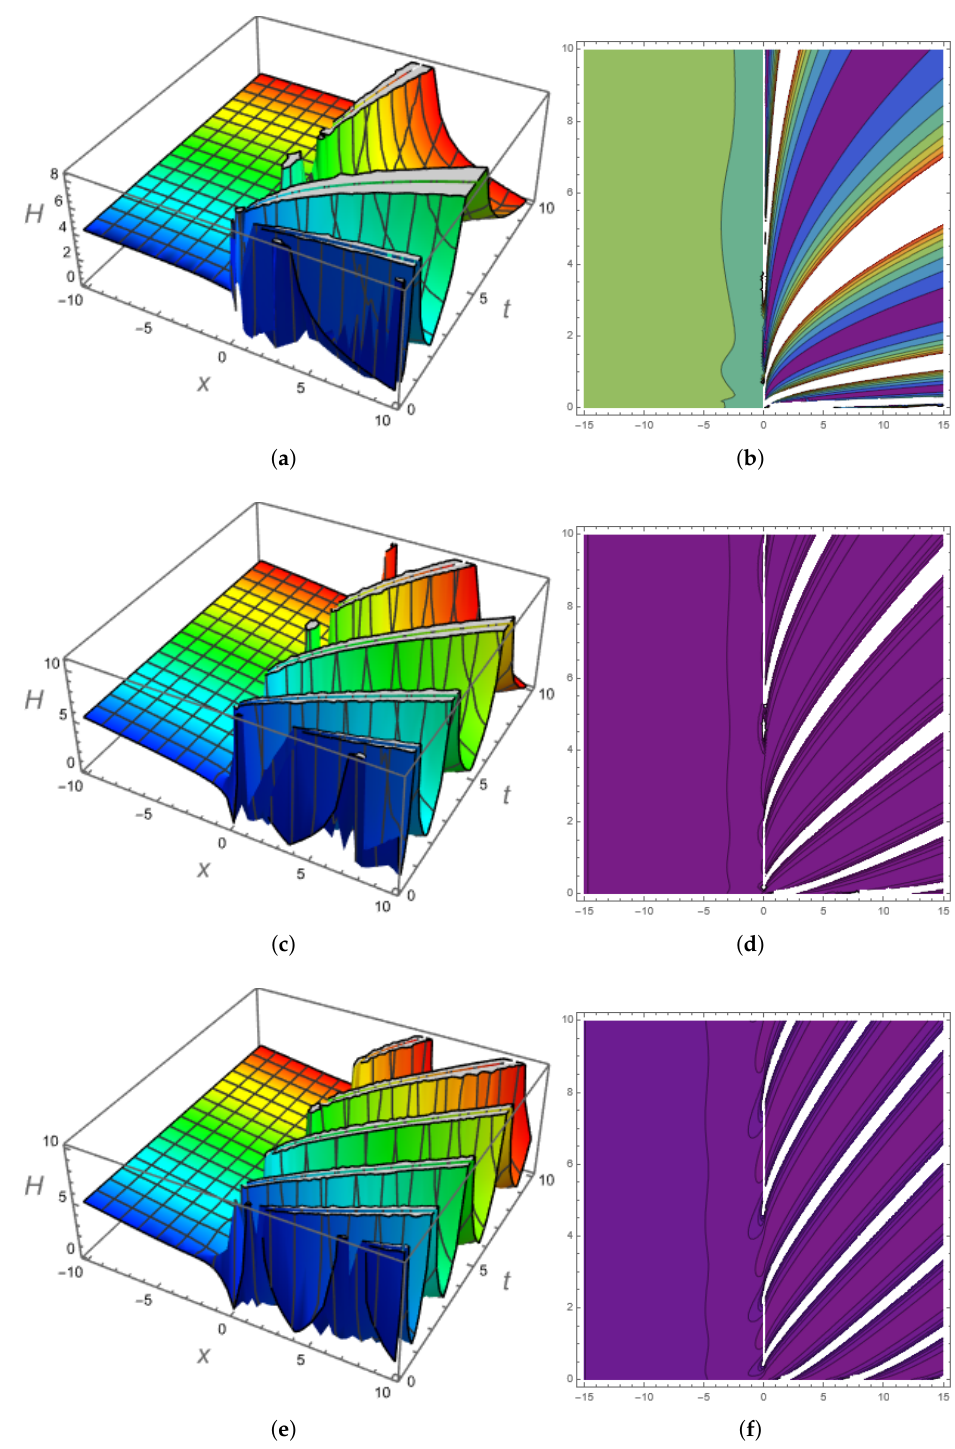
Figure 1. Trigonometric function solution of H 1 ( x , t ) for the values of α = − 1, κ = 0.1, µ = 0.9, δ = 0.01, γ = − 2. ( a ) 3-D wave profile at fractional order ζ = 0.1. ( b ) Contour wave profile at fractional order ζ = 0.1. ( c ) 3-D wave profile at fractional order ζ = 0.5. ( d ) Contour wave profile at fractional order ζ = 0.5. ( e ) 3-D wave profile at fractional order ζ = 0.7. ( f ) Contour wave profile at fractional order ζ =